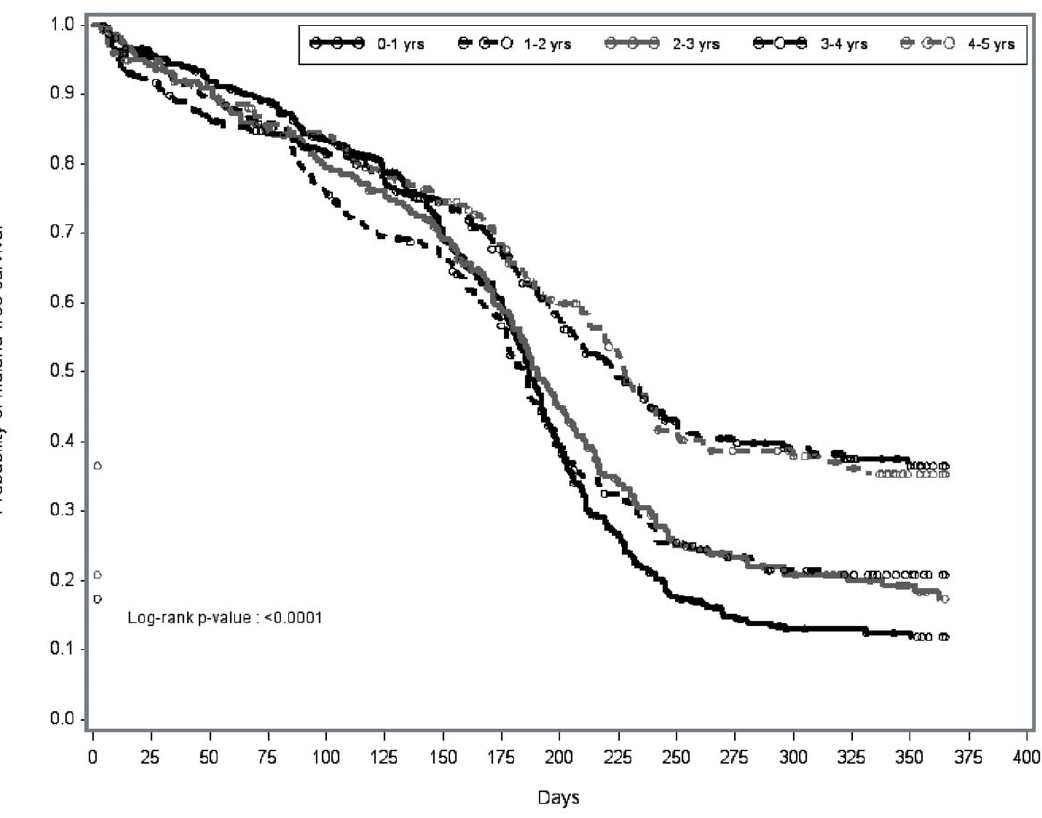
Figure 3. Time to first malaria episode among children 0–5 years evaluated by active surveillance from the low through high transmission season.